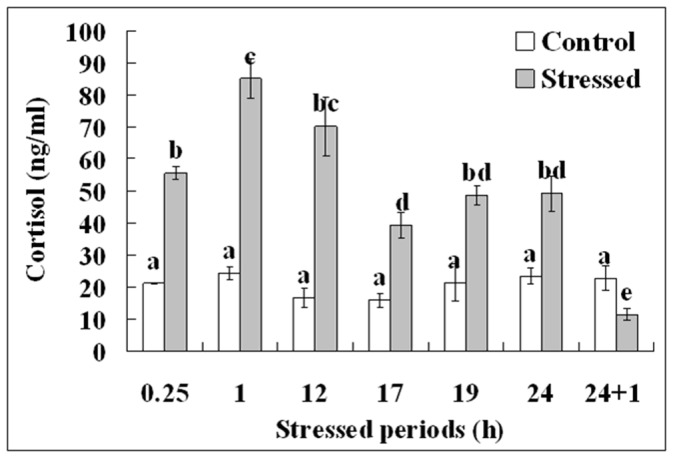
Serum cortisol concentrations after mice were exposed to cats for different times starting from 24 h following eCG injection.Each treatment was repeated 6 times using blood samples from 6 individual mice. Values without a common letter above their bars differ significantly (P<0.05).